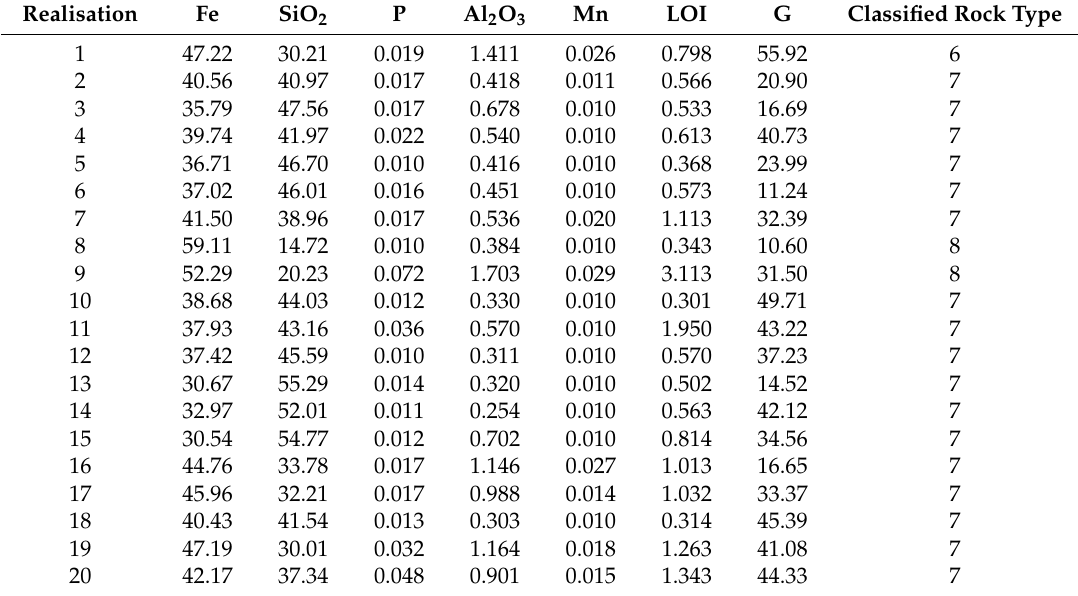
Table 7. Simulated grades and granulometry, and associated rock type, for 20 realisations of block n ◦ 1, interpreted as rock type 6 (compact itabirite) by mining